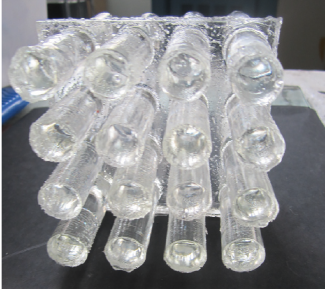
Figure 4: Resin light guide body.